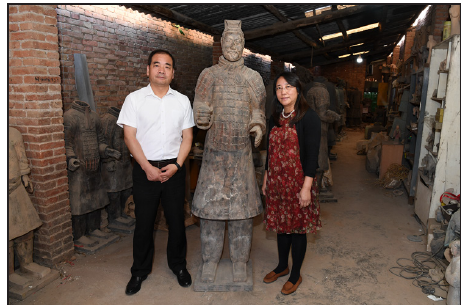
Figure 1: Shiao Ma, who sculpted our terracotta warrior, comparing its head to that of Thilo Rehren, Professor of Archaeo- logical Materials and Technology, Institute of Archaeology (Photo Weidong Zhou).